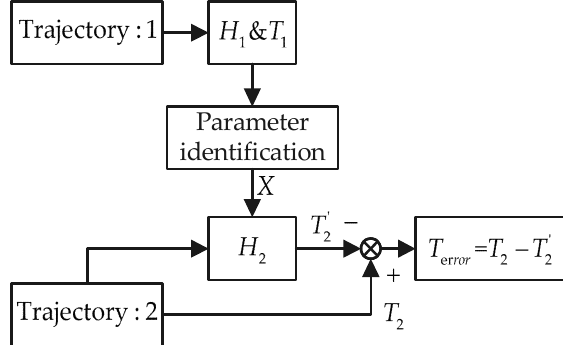
Figure 7. Quantitative evaluation method for identification accuracy.